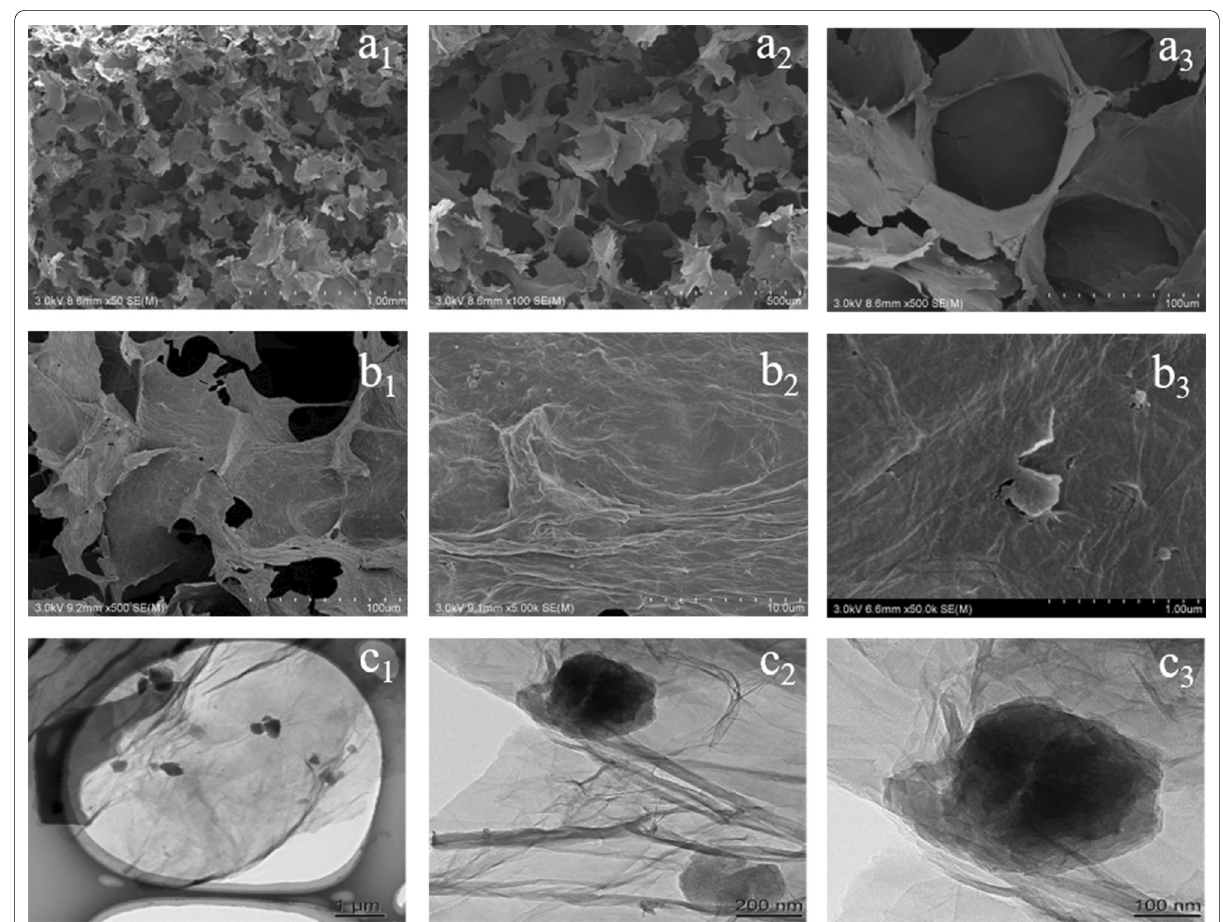
Fig. 1 SEM images with different magnification of rGA ( a 1 – a 3 ) and BC/rGA ( b 1 – b 3 ), and TEM images with different magnification of BC/rGA ( c 1 – c 3 )